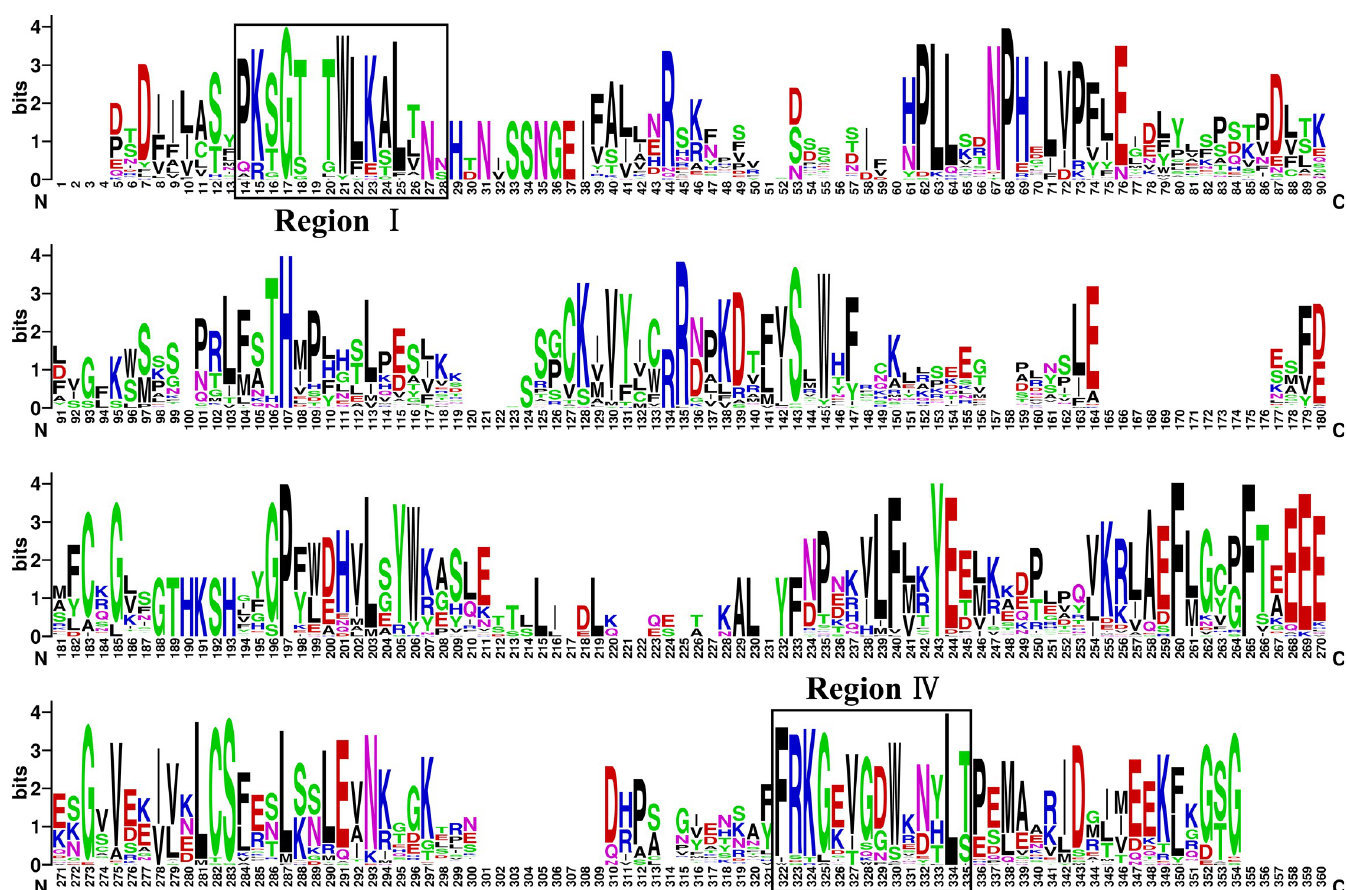
Fig 4. The SOT domain is highly conserved in many regions in Brassica rapa . In this figure, the height of each amino acid character represents the relative conservation of the sequence at that position. Highly conserved regions I and IV are indicated with